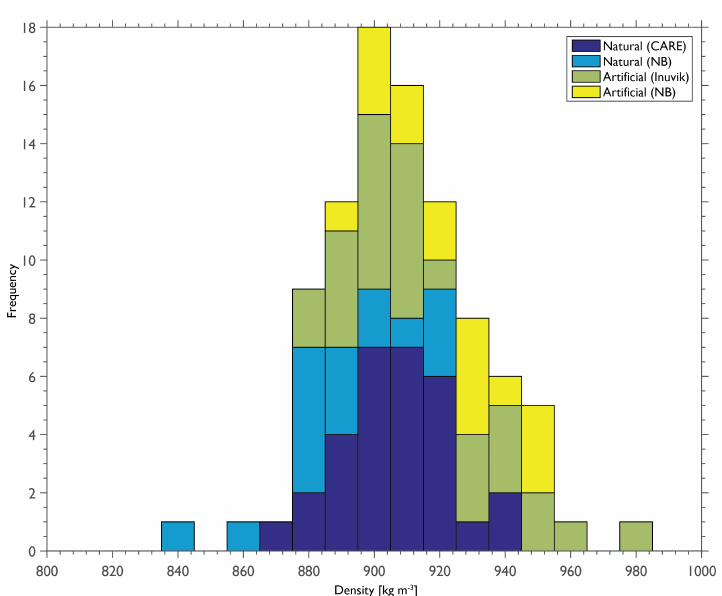
Figure 2. Summary of ice layer density measurements. Stacked histogram showing frequency of each density measurement, colours show distribution of artificial and natural ice layers across multiple